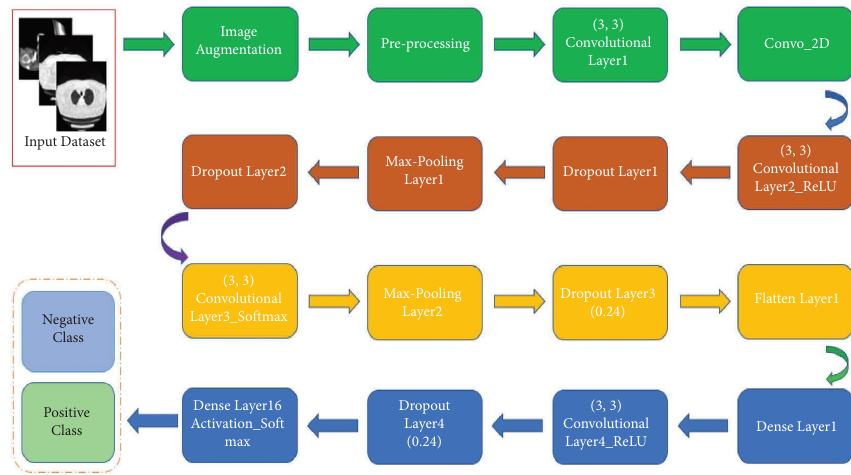
Figure 1: Workfow diagram of the proposed model utilizing the ECNN technique.